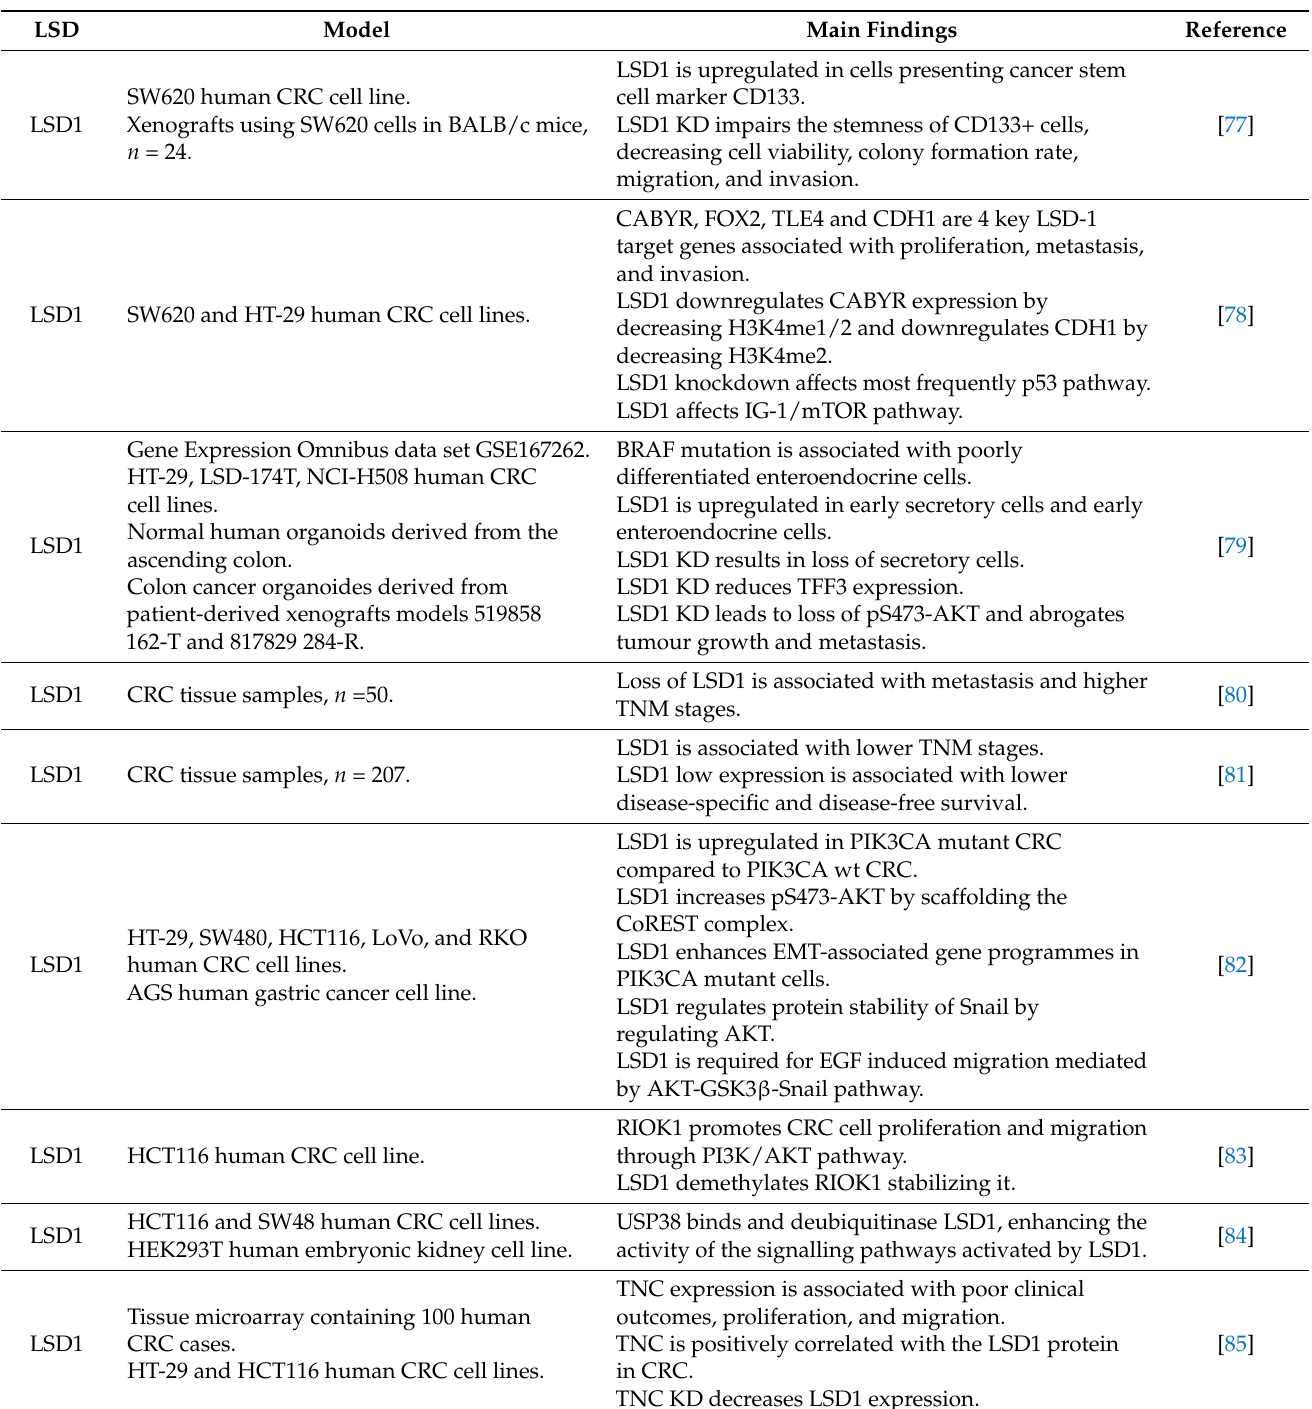
Table 4. Recent studies on LSD1/2 in colorectal